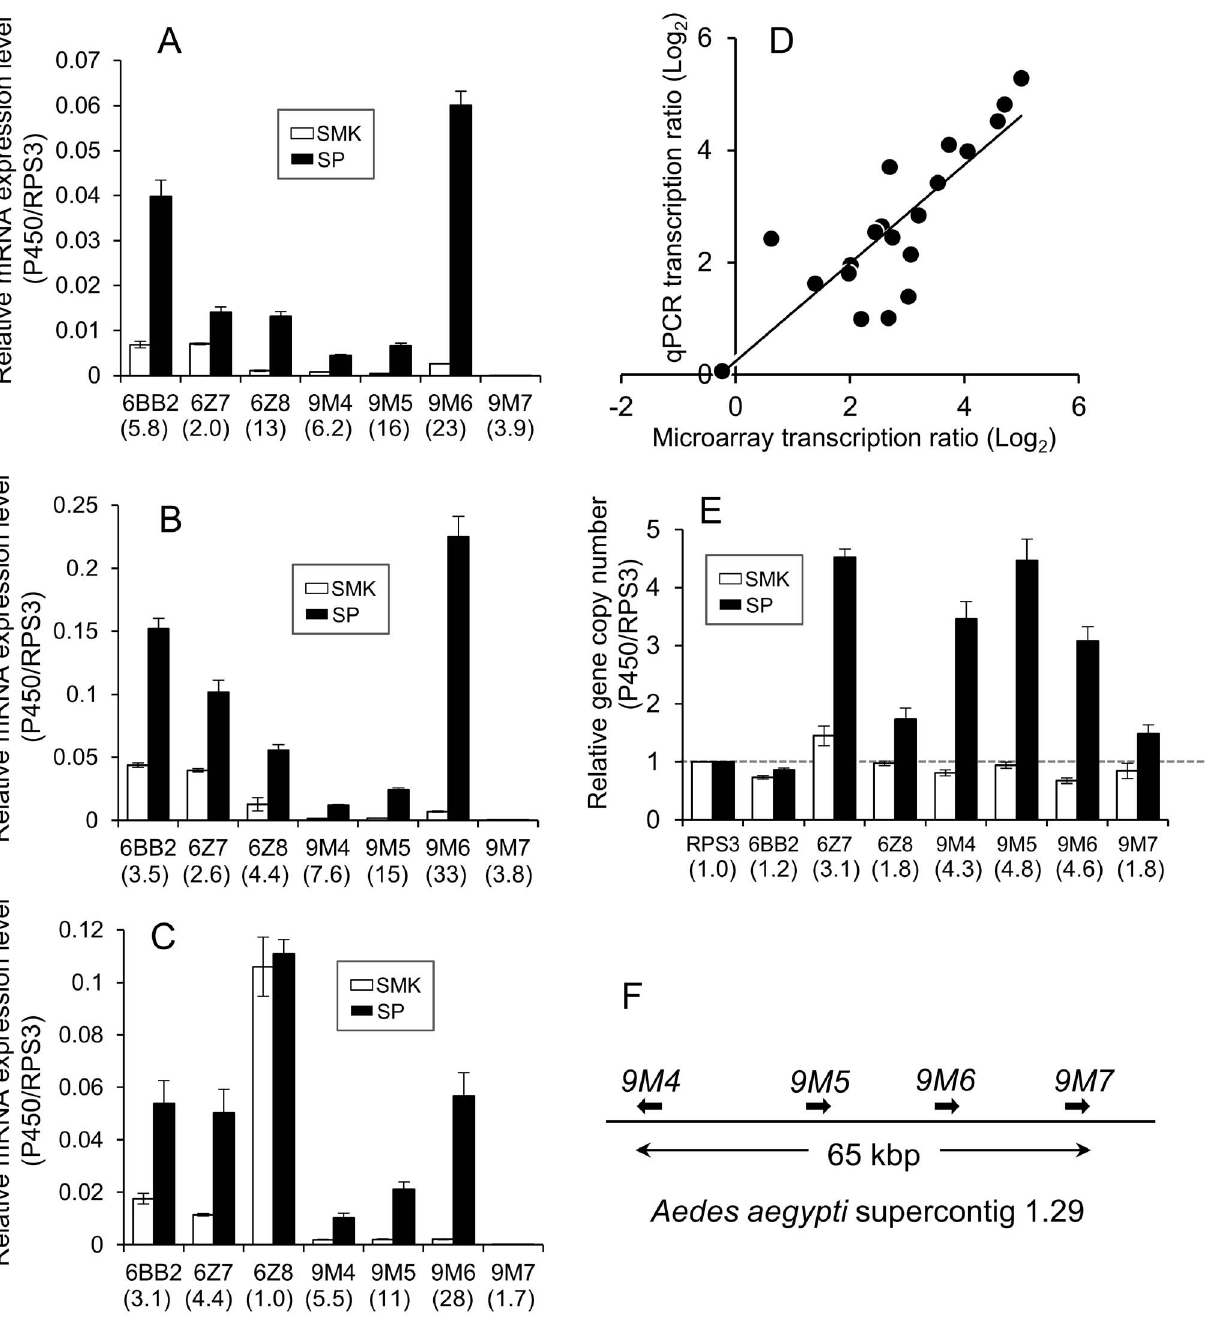
Figure 5. Real time quantitative PCR analysis of selected genes from the microarray experiments. Transcription levels of seven P450 genes were individually validated in adult female (A), adult male (B), and fourth instar larvae (C) in SP and SMK strains of Aedes aegypti . Ribosomal protein S3 gene ( RPS3 ) was used to normalize the data. Expression ratios (SP/SMK) are expressed in parentheses. (D) Correlation between the microarray and real time quantitative PCR (R 2 = 0.824). (E) Gene copy number of 7 P450s and RPS3 quantified by real time PCR. The ratios of relative copy number (SP/SMK) are expressed in parentheses. (F) Gene clusters of cytochrome P450 and the CYP9M subfamily on the A. aegypti supercontig 1.29 on the 2nd chromosome. The error bars represent standard errors of three (A, B, and C) and eight (E) biological